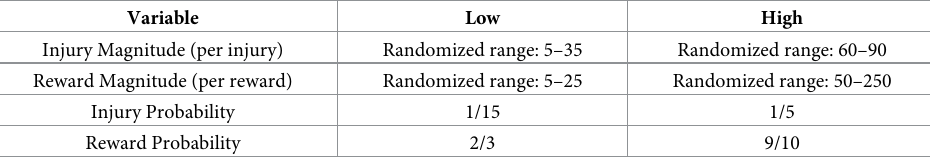
Fig 1. APRT trial example. Top left: the participant begins a new trial with 0 points, 100 health, and an image (with description) of a physical risk-taking activity. The yellow border color indicates a high probability of injury (versus a blue color indicating a low injury probability); the solid border color indicates a high probability of being rewarded (versus a checked border indicating a low reward probability). Border color and solidity only changes at the start of new trials, and the magnitude of reward and injury is revealed only through proceeding through the trial and experiencing each outcome. Top right: the participant has pressed the proceed (“p”) button and won 63 points as a result. Bottom right: another “p” press has caused an injury, and thus the participant lost 64 health and points. Bottom right: another “p” press has caused an injury severe enough for health to drop below 0, so the participant is shown a “death” screen and loses any points gained during this trial. If the participant does not “die” after a “p” press, they may press the quit (“q”) button at any time to save all points earned on the trial to their grand total (not displayed) and proceed to the next trial. The trial’s points are reset to 0; the health to 100; and a new picture, border, and description are displayed. https://doi.org/10.1371/journal.pone.0258826.g001 probabilities for the different reward and injury conditions, as well as the ranges of health and points lost per injury and points gained per reward. Participants are informed that the border pattern surrounding each trial picture indicates the reward probability of that trial (solid = high reward probability, striped = low reward probability), whereas the color of the border indicates the injury probability (blue = low risk of injury, yellow = high risk of injury). Table 1. Summary of reward/injury probabilities and